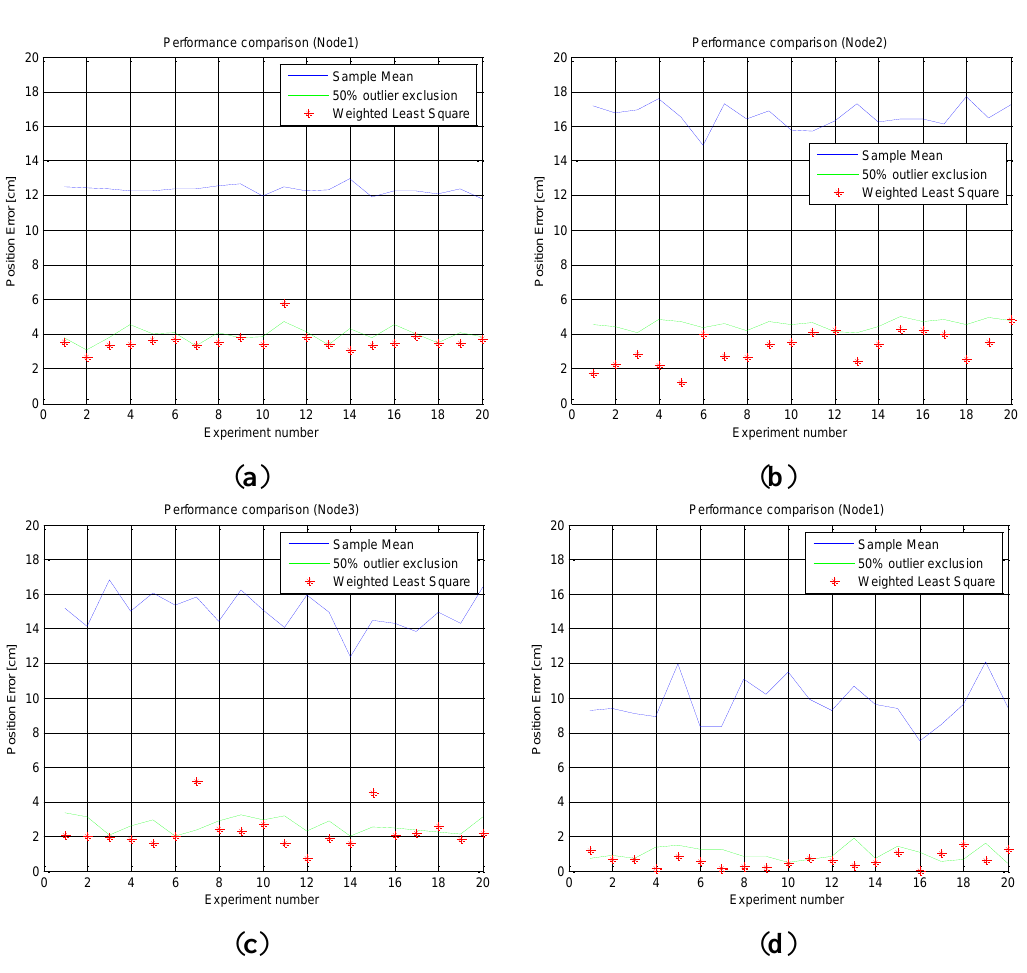
Figure 13. Position error of the repeated tests with the error reduction methods. ( a ) Node 1: (26 cm, 0 deg), ( b ) Node 2: (31.17 cm, 30 deg), ( c ) Node 3: (26 cm, 90 deg), ( d ) Node 1: (100 cm, 0 deg).